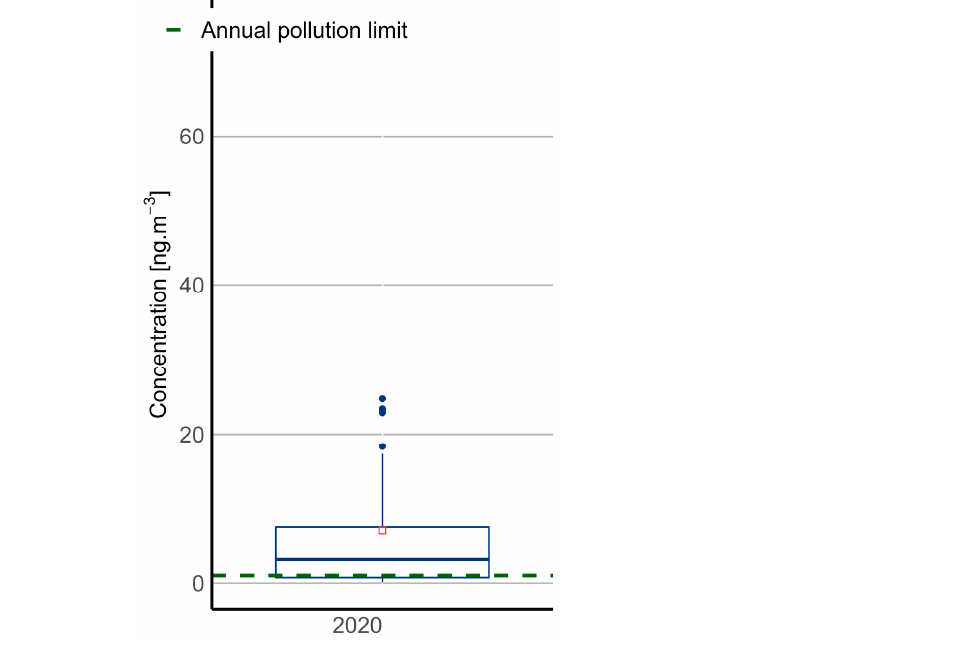
Figure 15. Boxplot of daily benzo[ a ]pyrene concentrations: V ěřň ovice station, 2020 (red squares indicate average concentrations; dashed line indicates the annual limit value for BaP).